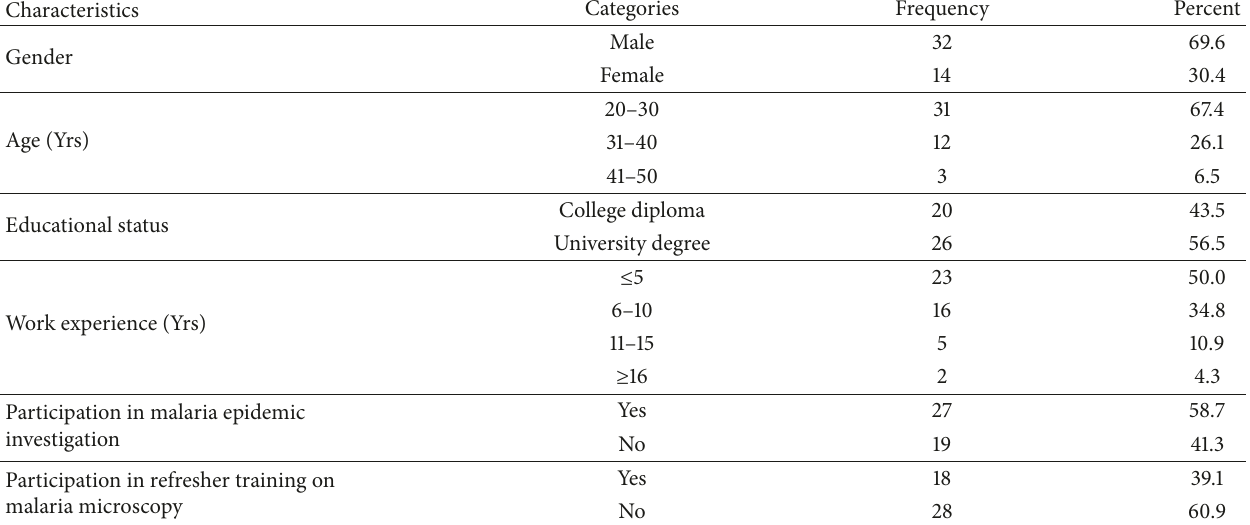
Table 1: Demographic characteristics of the study participants’ in Tigray, North Ethiopia,